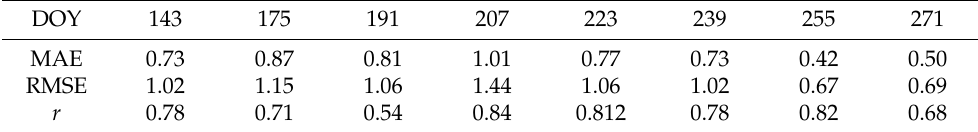
Figure 6. Bar graph of LAI predictions statistics (MAE, RMSE, and r ) at the CSD area. Table 4. Quantitative validation of LAI for all input days at the CSD